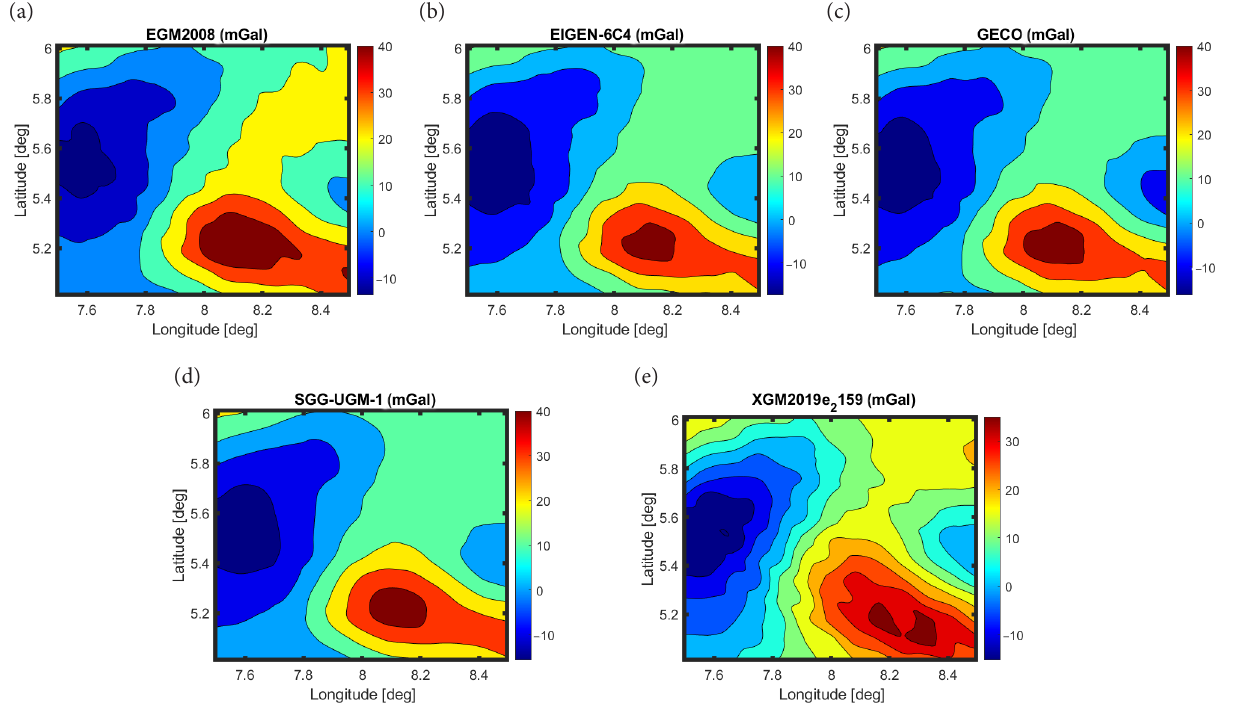
Figure 12. Tailored GGM-derived Bouguer map of the Afikpo Basin: a – EGM2008; b – EIGEN-6C4; c – GECO; d – SGG-UGM-1; and e